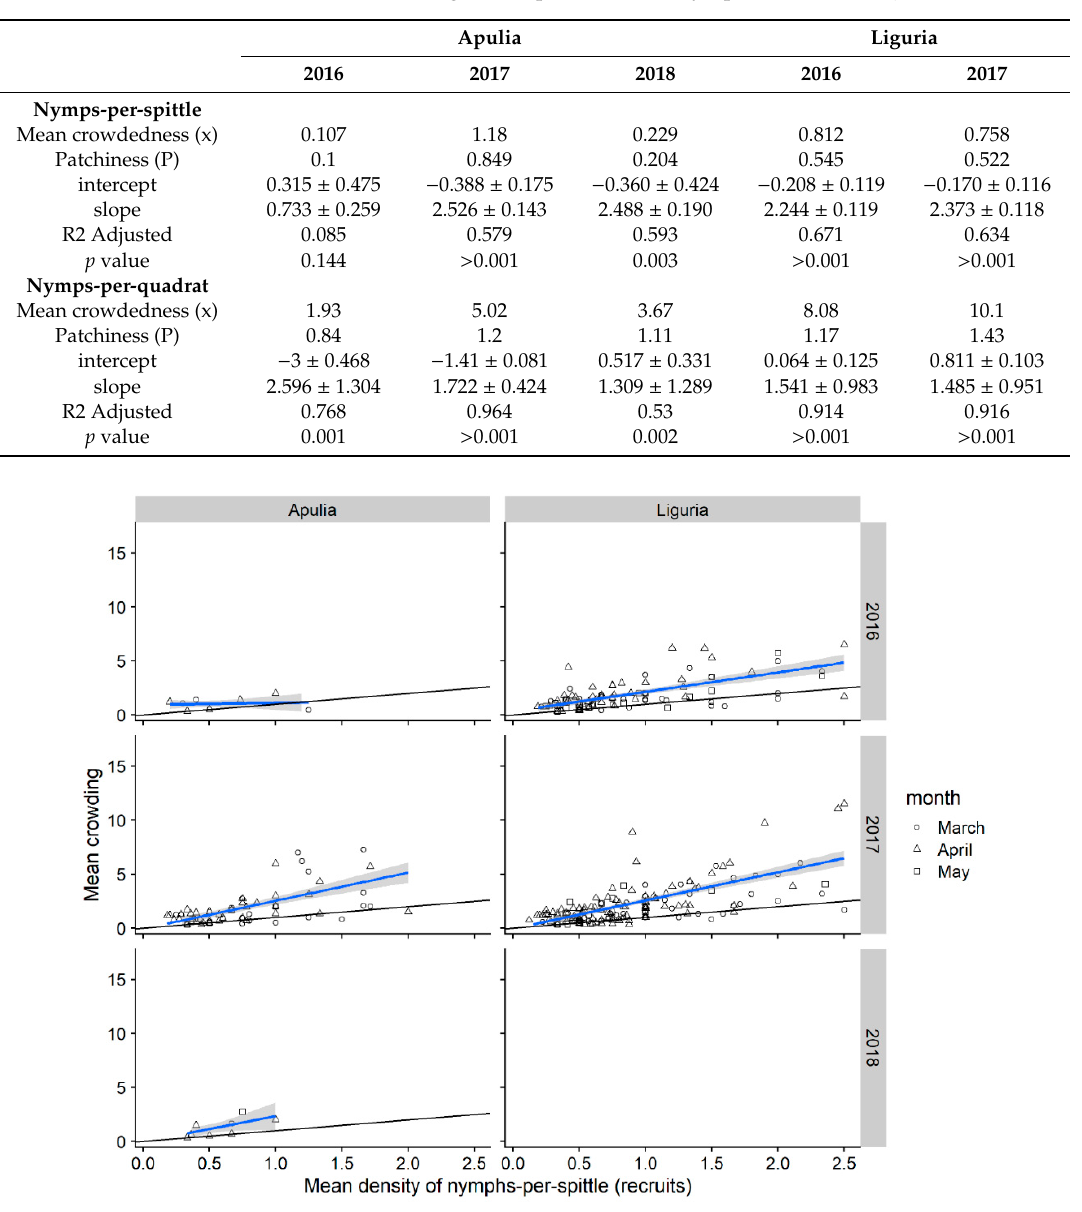
Table 1. Iwao’s mean crowdedness regression parameters of nymphs of Philaenus spumarius .